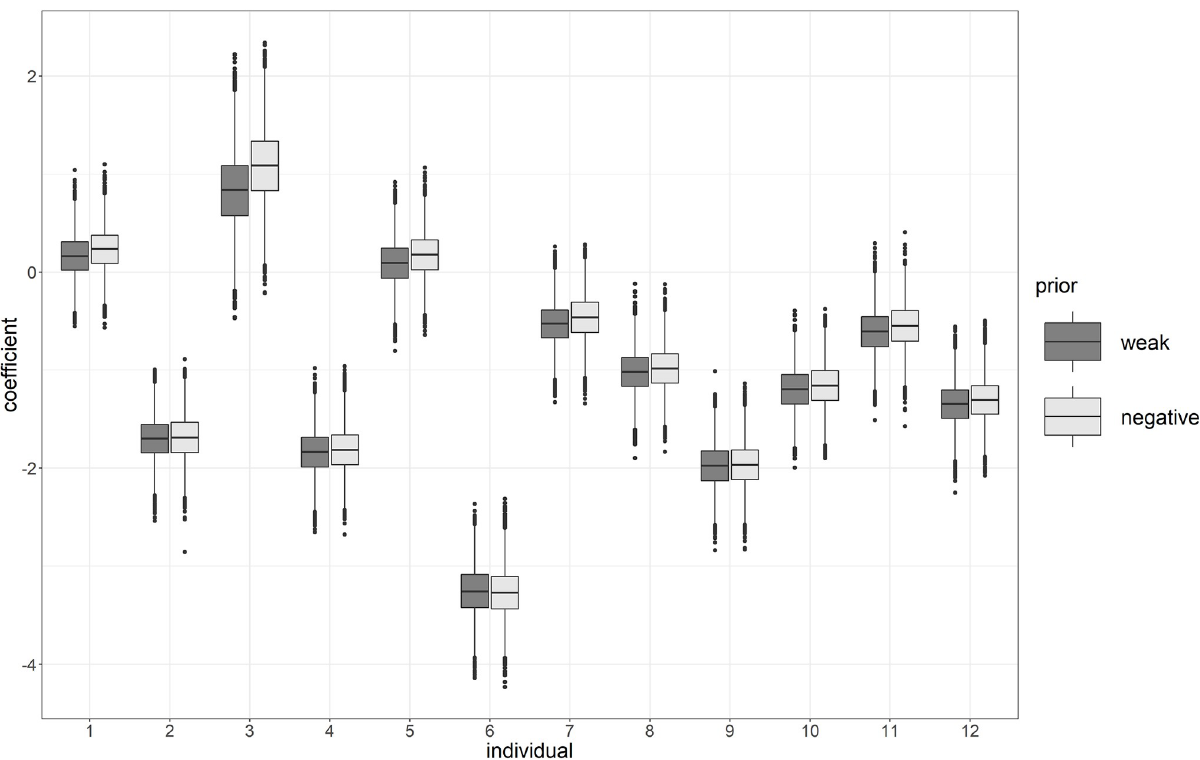
Fig 9. Individual estimates for the weight loss using a weak and a negative prior, condition 3 versus